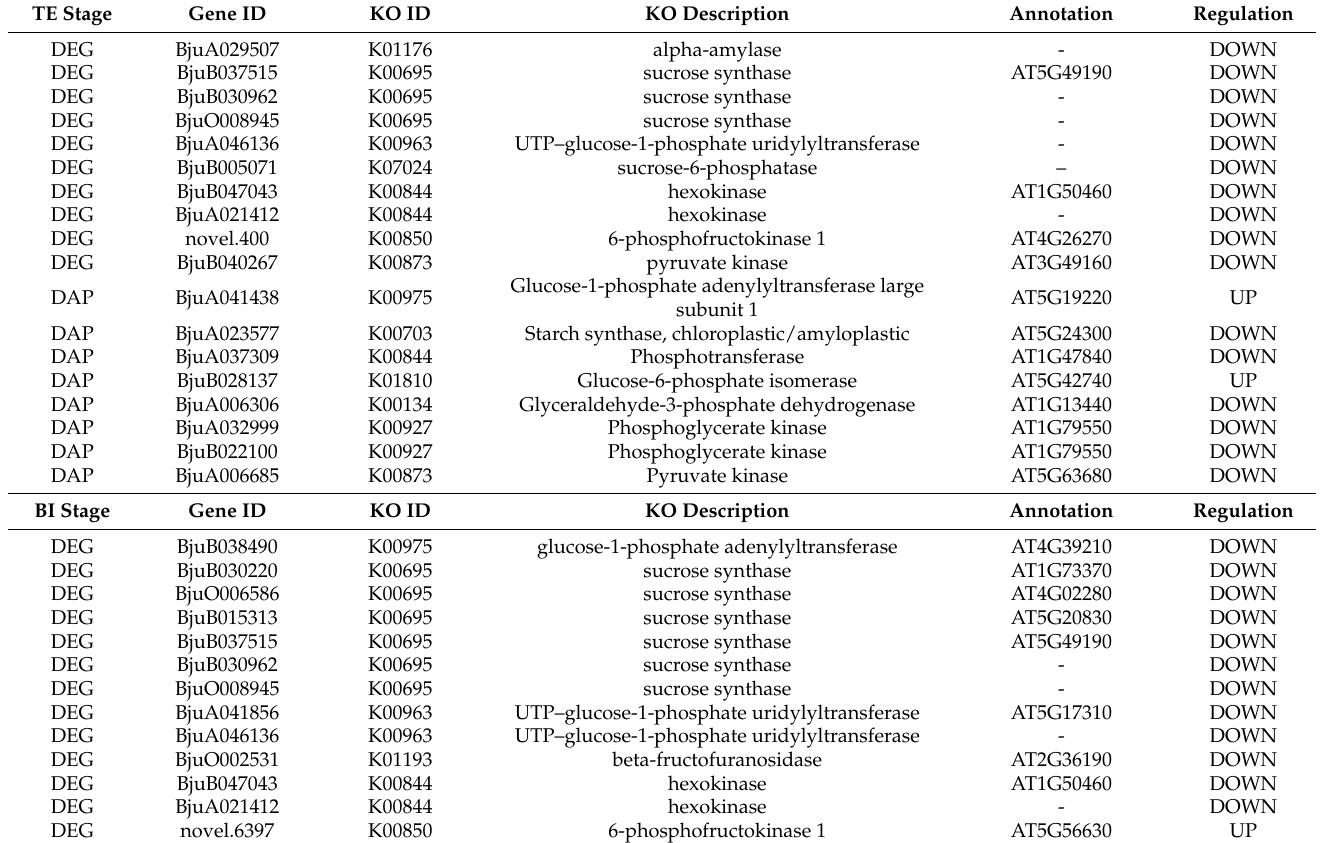
Table 1. List of DEGs and DAPs associated with carbohydrate metabolism in 09-05A/B lines of B. juncea